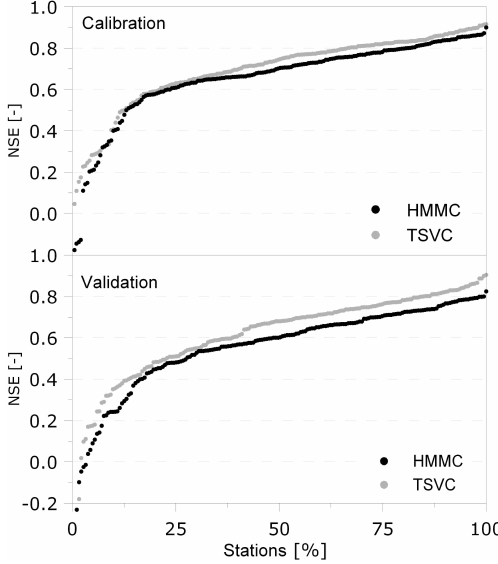
Fig. 8. Sorted model performance for NSE for both models during calibration and